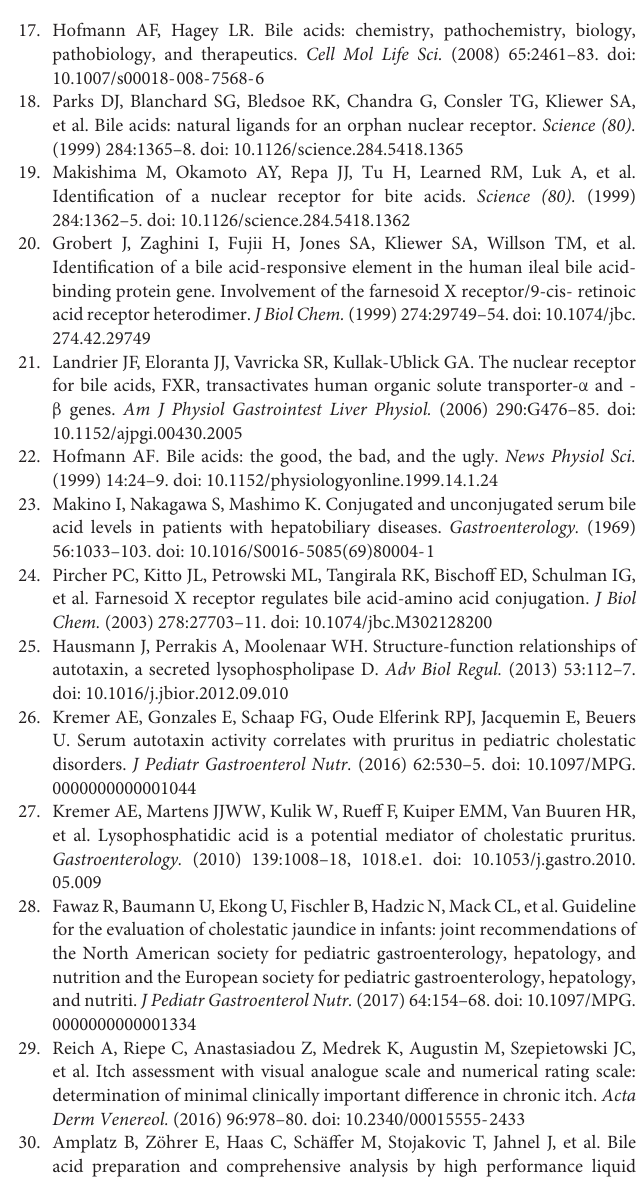
Supplementary Figure 1 | Overview of groups and number of all pediatric participants. ASC, autoimmune sclerosing cholangitis; PFIC, progressive familial intrahepatic